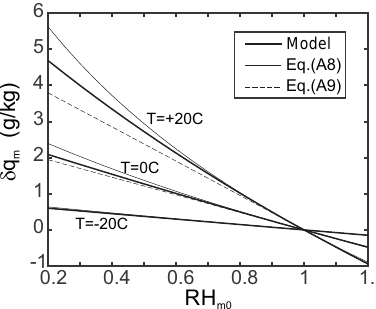
Figure A1. Amount of evaporated liquid water δq m required for saturation of a cloud volume with initial humidity RH m . Compar- isons of the modeled δq m and that calculated from Eqs. (A8) and (A9) for three temperatures T m0 = − 20, 0 and 20 ◦ C. Calculations were performed for P =